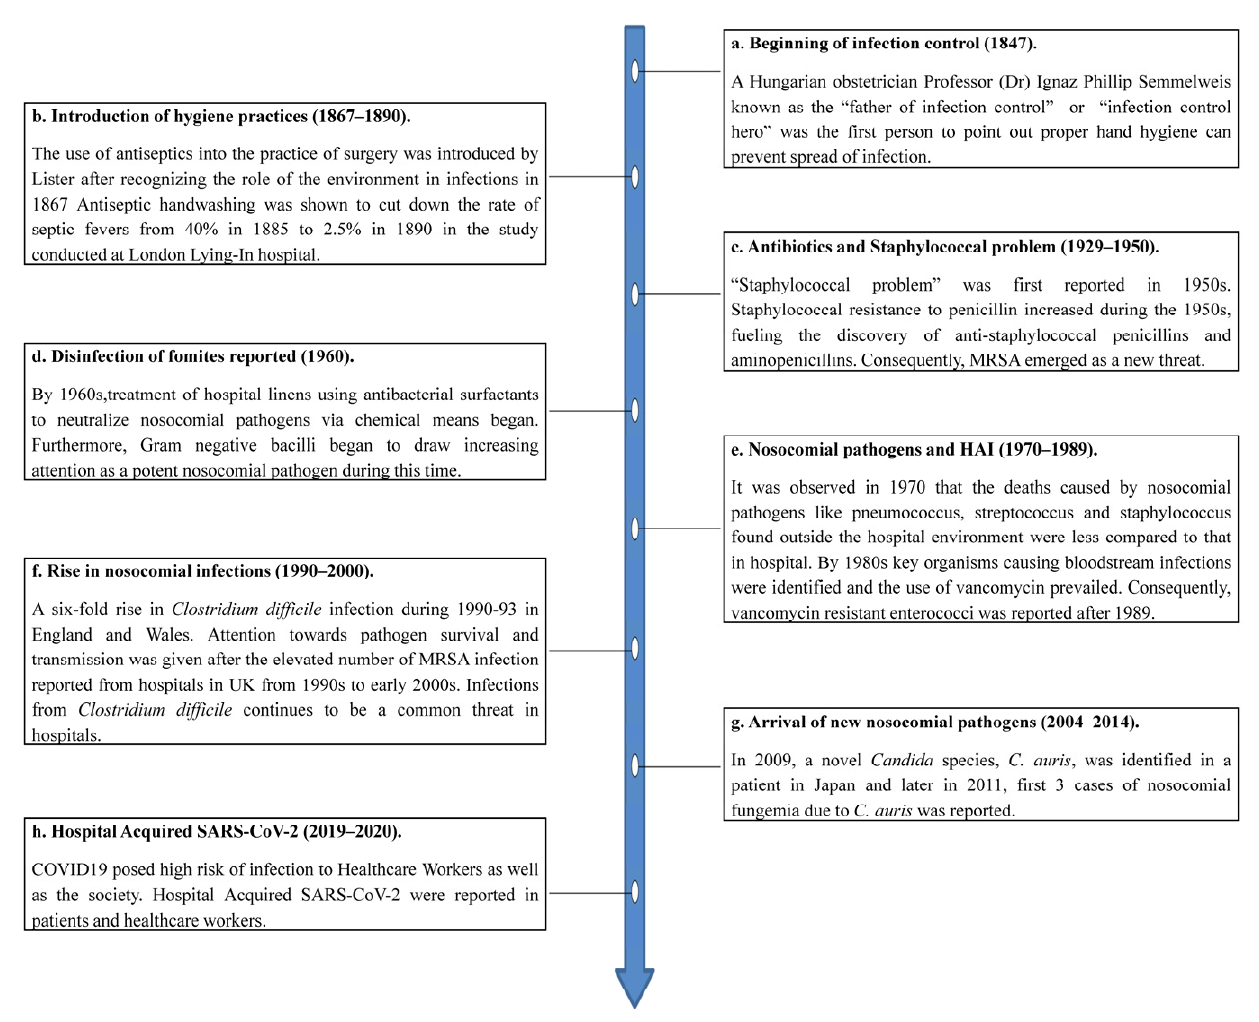
Figure 1. Historical overview of HAIs. References: a. [20 ‐ 22], b. [22,23], c. [22,24,25], d. [26,27], e. [26,28], f. [3,29,30], g. [31,32], and h. [33 ‐ 35]. It can be observed that the threat is still present, with a clear potential for morbidity and mortality.